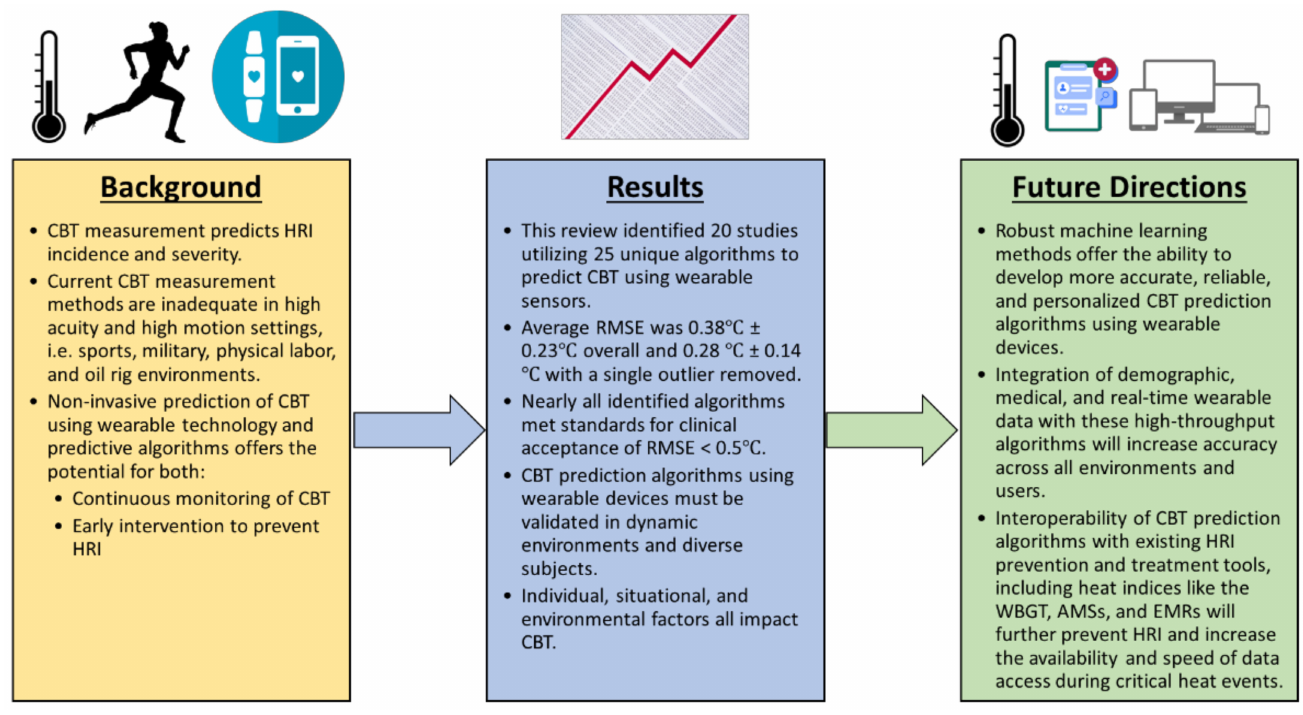
Figure 6. Conclusions from this review and proposed future directions for the technology. HRI = heat-related illness, CBT = core body temperature, RMSE = root mean square error, WBGT = wet bulb globe temperature, AMS = athlete management system, and EMR = electronic medical